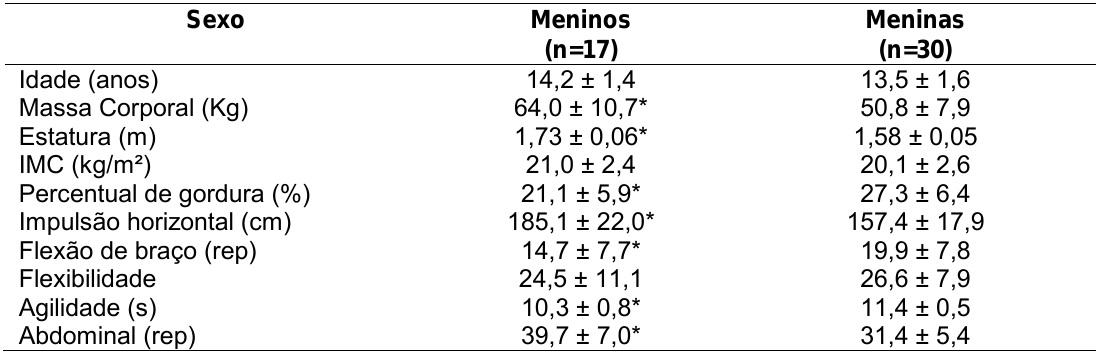
Tabela 1. Diferença entre os gêneros para as características antropométricas e do desempenho motor.